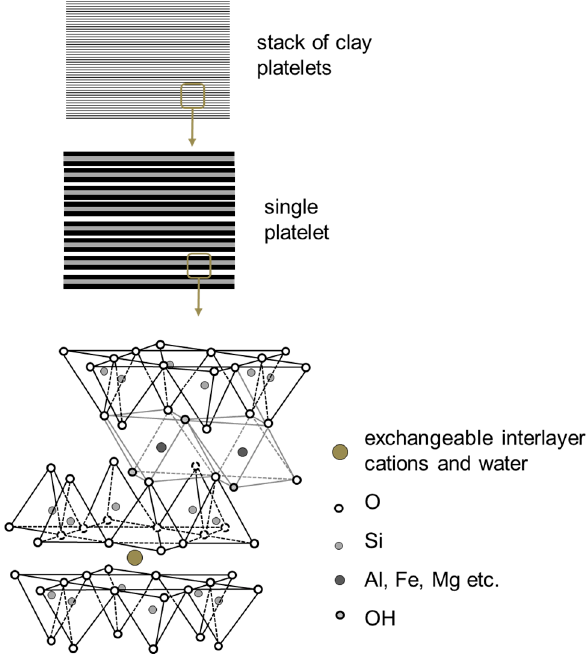
Figure 8. Structure of montmorillonite (phyllosilicate clay). Adapted from [133].